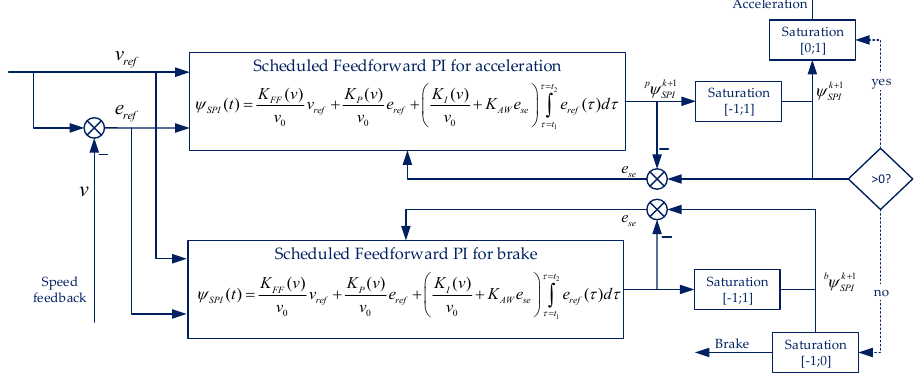
Figure 7. The SFF-PI architecture for longitudinal